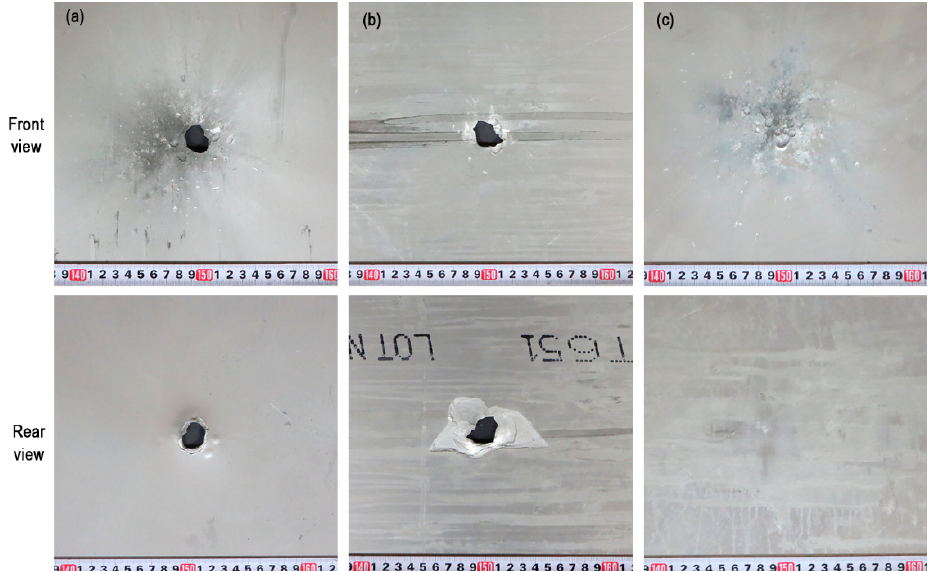
Figure 6. The experimental result of the rear walls (Configuration A: rear wall of ( a ) A-1; ( b ) A-2; ( c ) A-3).